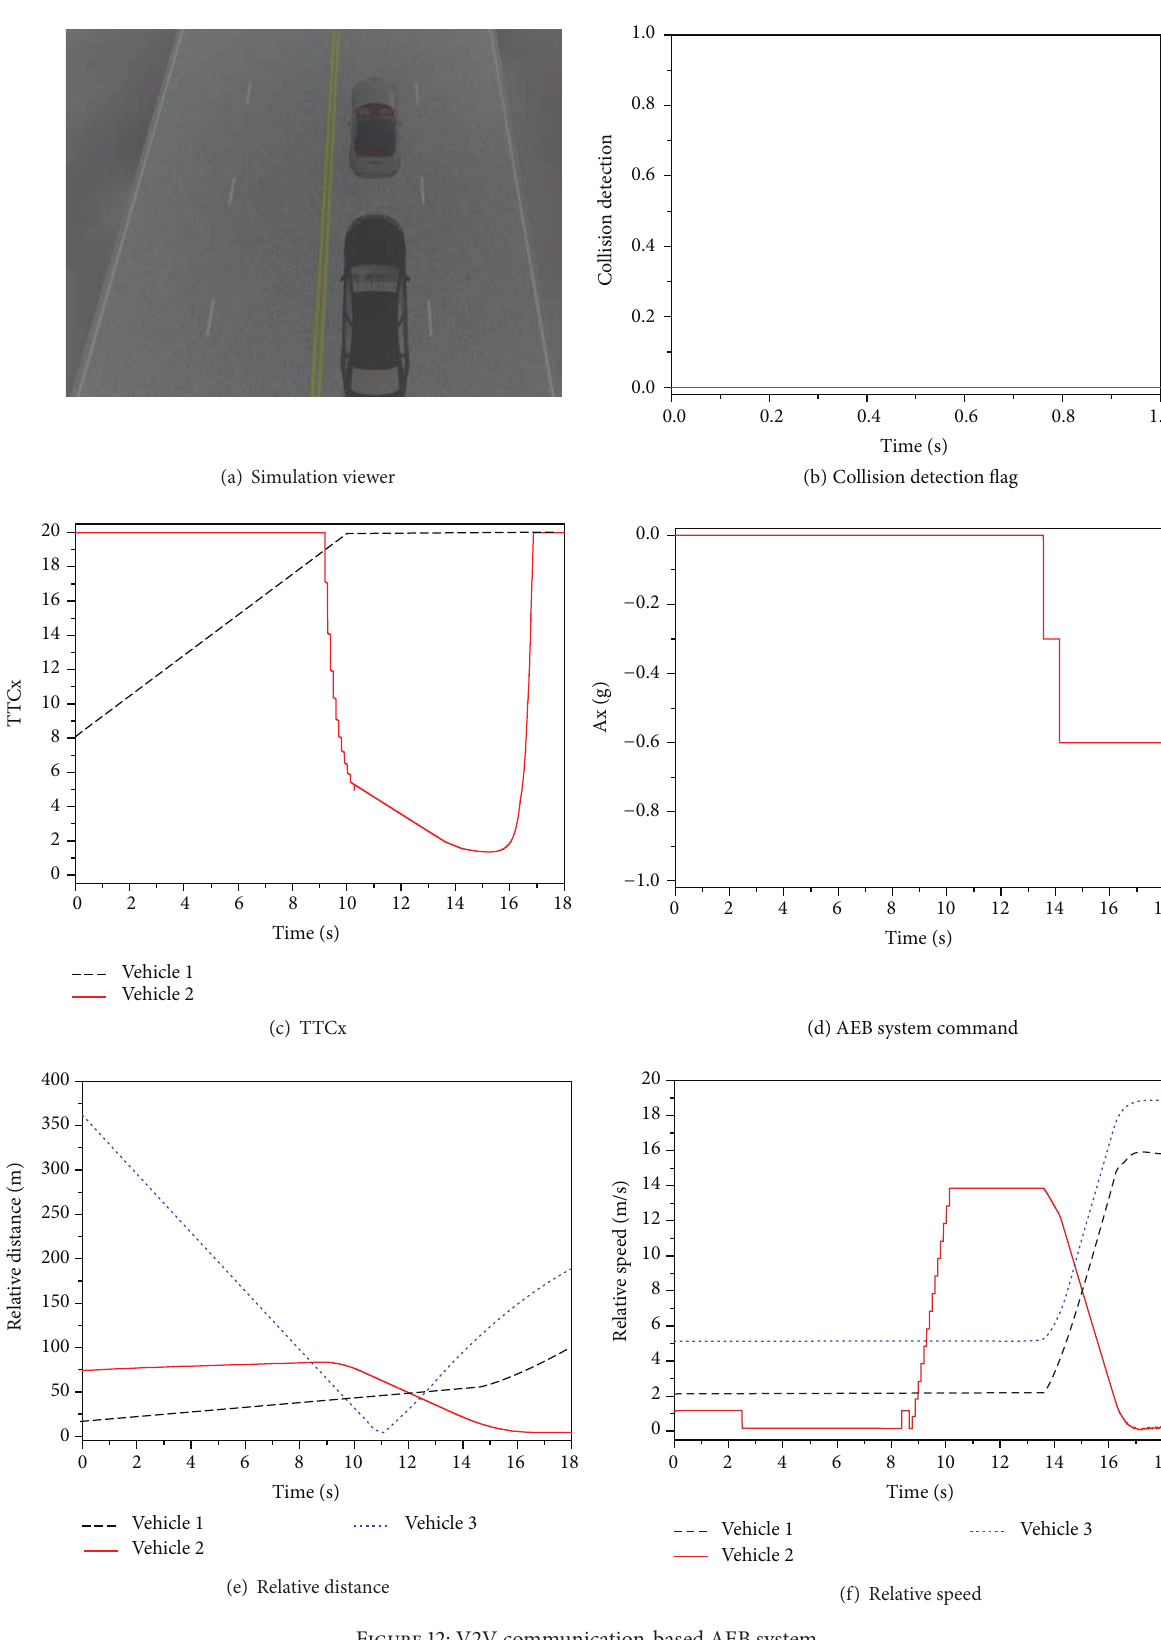
Figure 12: V2V communication-based AEB